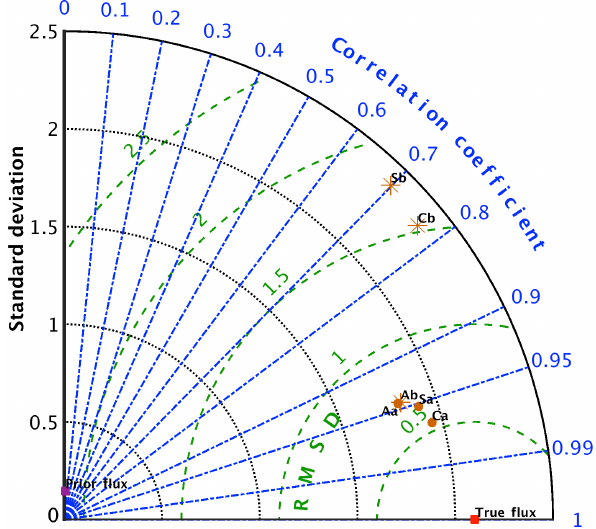
Figure 4. Taylor diagram showing the correlation coefficient, stan- dard deviation and root-mean-square difference of the concatenated time series of the monthly posterior fluxes from the TransCom3 land regions. Standard deviation of the time series is depicted on the vertical axis while the correlation coefficient with respect to the true flux time series is shown on the circular arc of the diagram. The root-mean-square difference of the time series is shown on the green arcs. Points S, A and C represent the simulations using mea- surements from only the surface stations, only the aircraft profiles and the combined network (surface + aircraft) respectively. “a” de- notes the control case simulation with well known boundary layer height, while “b” denotes simulations using reshuffled profiles with wrong boundary layer height. Points closer to the true flux point, near the lower right corner of the diagram, are a better